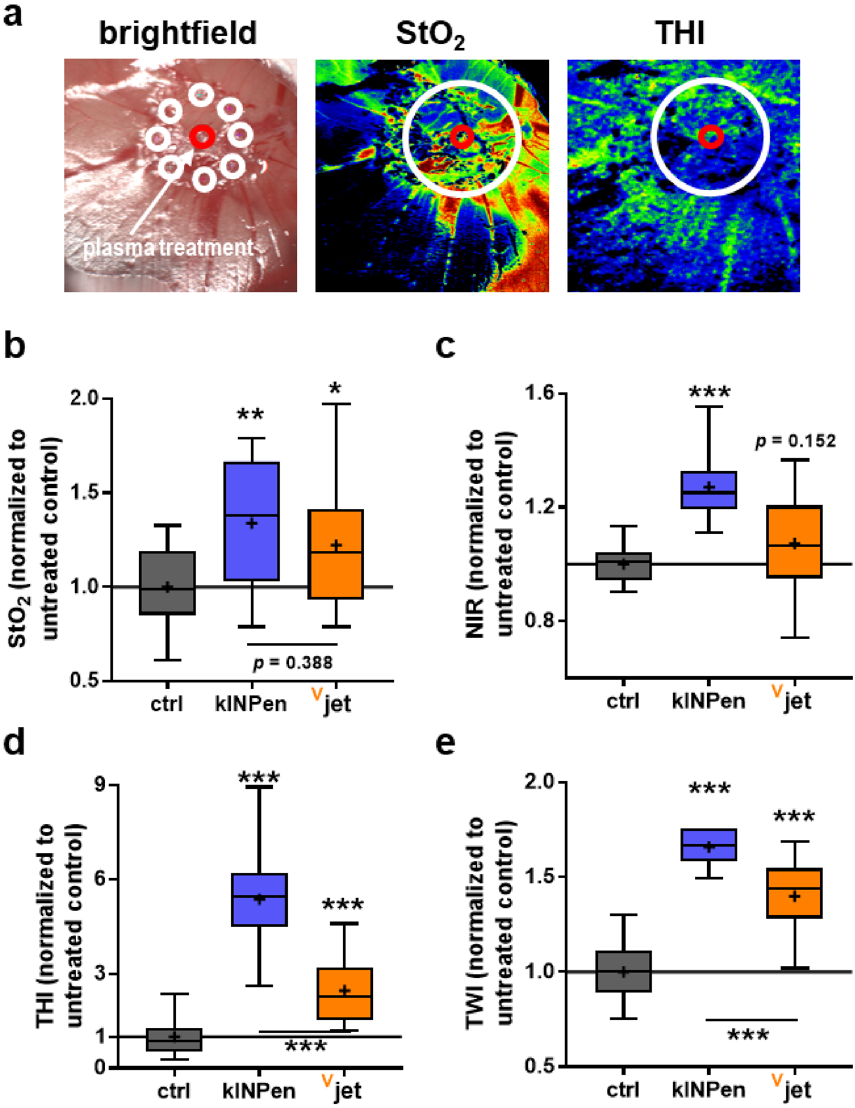
treatment site while the white circles represent the region in which eight ROIs were placed for quantification; ( b – e ) spectral data analysis to evaluate superficial tissue oxygenation (StO 2 , b ), near-infrared perfusion index (NIR, c ), tissue hemoglobin index (THI, d ), and tissue water index (TWI, e ). Spectral absorbance was normalized to untreated CAM. Data are min–max boxplots from 5 eggs per group. Statistical analysis was performed using one-way anova (***p <